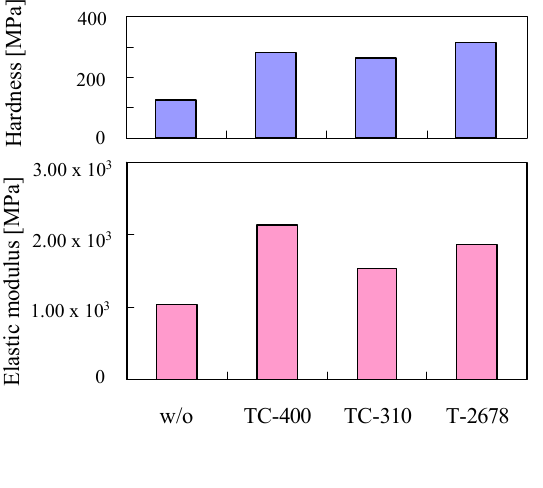
absence (w/o) and presence of a cross-linking agent (TC-400, TC-310, or TC-2678).